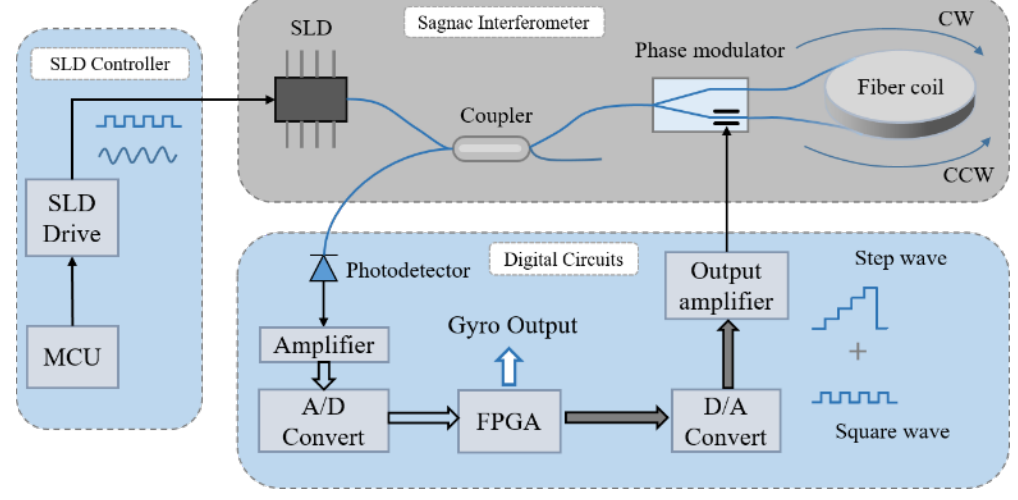
Figure 1. Fiber-optic gyroscope system components.